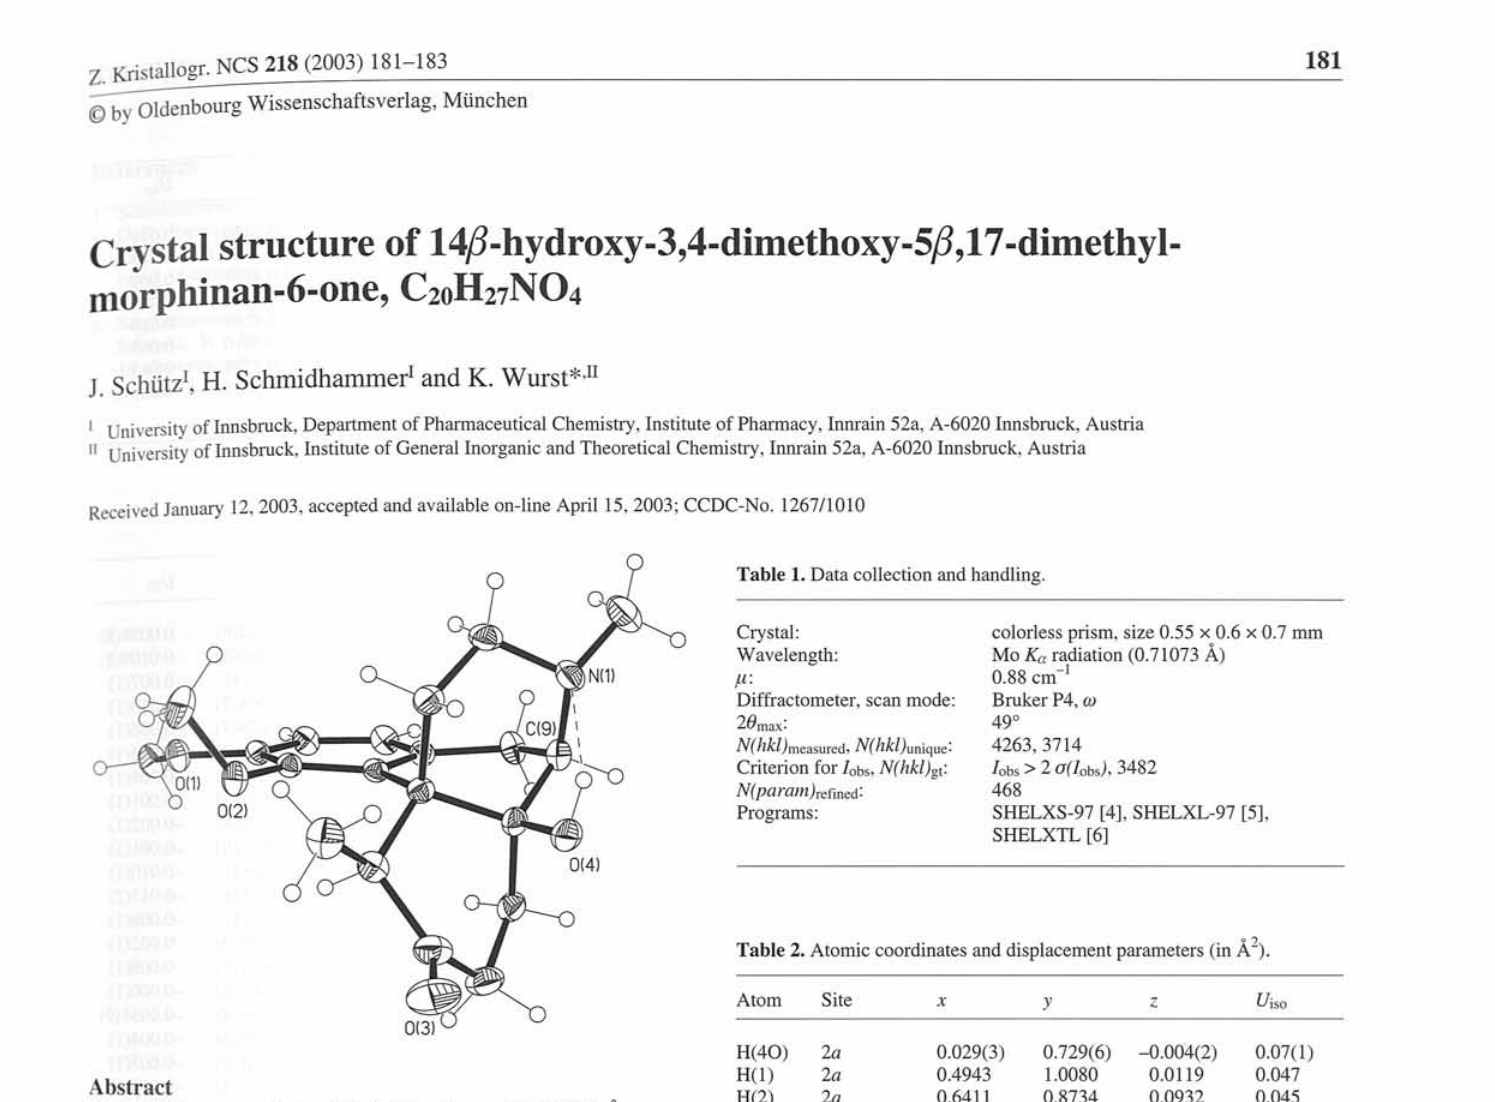
Table 2. Atomic coordinates and displacement parameters (in